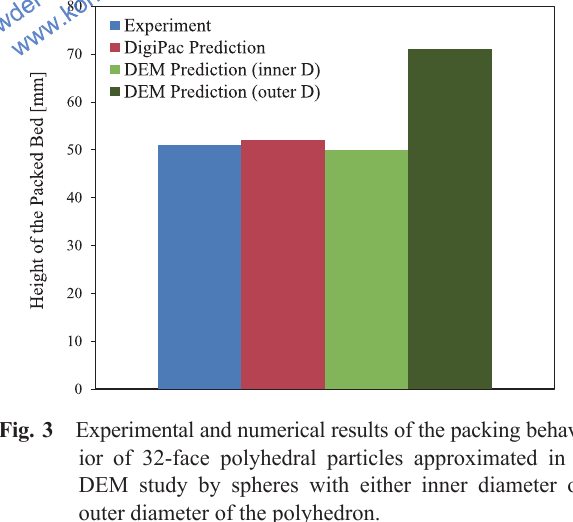
Fig. 3 Experimental and numerical results of the packing behav- ior of 32-face polyhedral particles approximated in a DEM study by spheres with either inner diameter or outer diameter of the